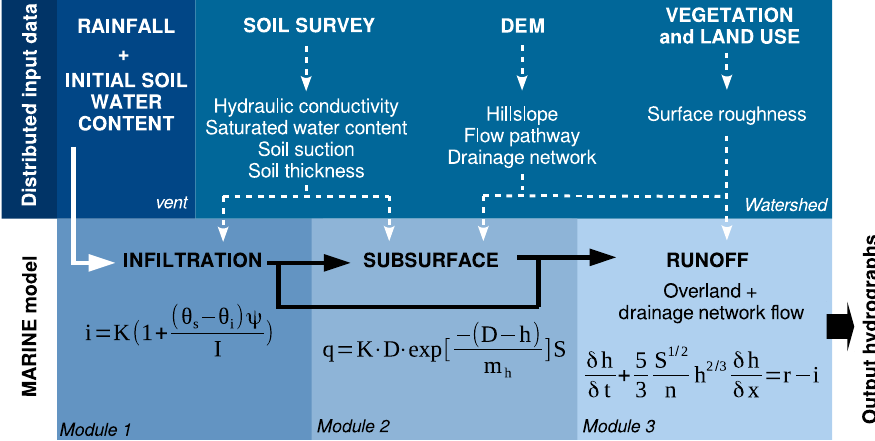
Figure 3. The MARINE model structure, parameters and variables. The Green–Ampt infiltration equation contains the following parameters: infiltration rate i (ms − 1 ), cumulative infiltration I (mm), saturated hydraulic conductivity K (ms − 1 ), soil suction at the wetting front (cid:57) (m), and saturated and initial water contents, θ s and θ i (m 3 m − 3 ), respectively. Subsurface flow contains the following parameters: soil thickness (m), lateral saturated hydraulic conductivity K (ms − 1 ), local water depth h (m), transmissivity decay with depth m h (m) and bed slope S (mm − 1 ). The kinematic wave contains the following parameters: surface water depth h (m), time t (s), space variable x (m), rainfall rate r (ms − 1 ), infiltration rate i (ms − 1 ), bed slope S (mm − 1 ) and Manning roughness coefficient n (m − 1 / 3 s). Module 2 described in this